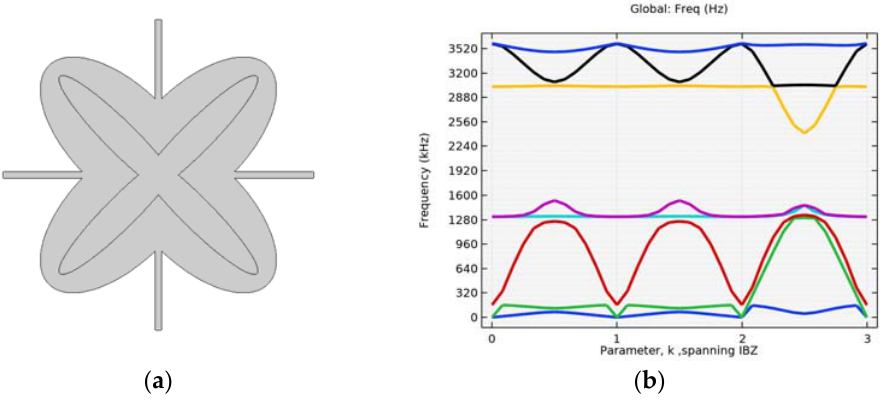
Figure 6. Response for inner ellipse 170 × 30, rod 6 mm with one band gap, between 5th and 6th eigenfrequency (1520–2400 Hz). ( a ) microstructure, ( b ) responce for first eigenfrequenciew.